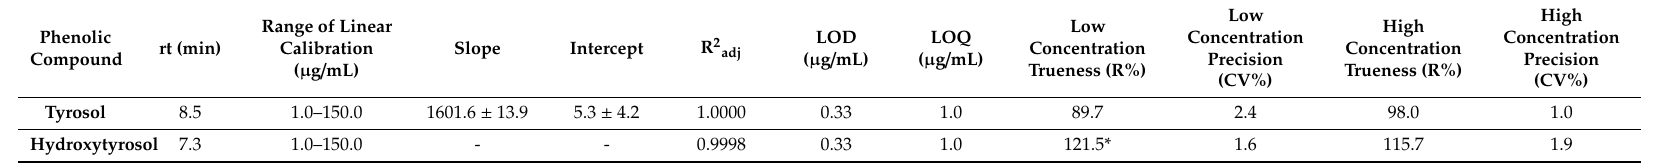
Table 2. Quality parameters for method validation regarding the external standards used for the quantitative evaluation. Phenolic Compound